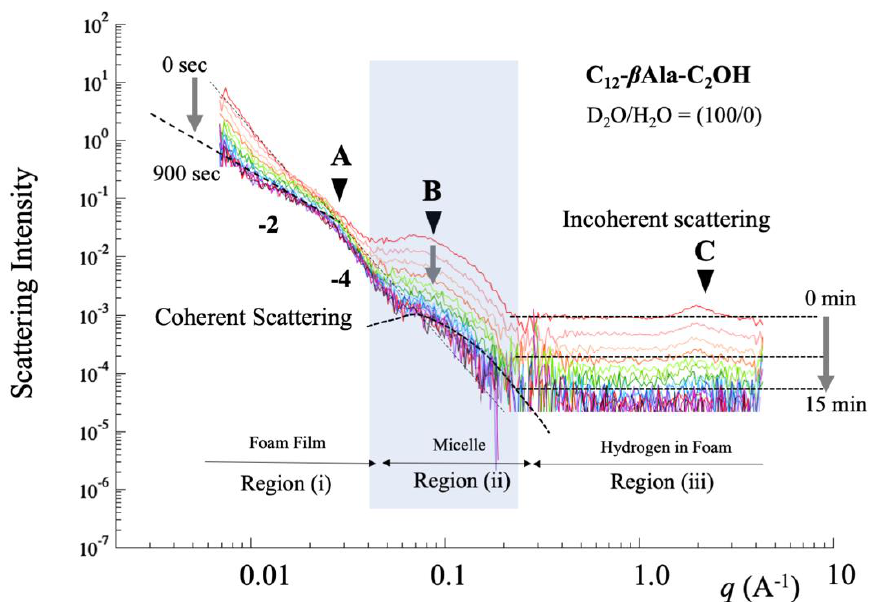
Figure 11. Time-resolved coherent SANS obtained for the C 12 –EtOH– β Ala solution of 100% D 2 O with a time interval of 1 min, covering a wide q -region from 0.01 to 4 A − 1 . At low q values, coherent scattering of the film was dominant, whereas at high q values incoherent scattering of hydrogen was dominant. The characteristic q -positions are indicated by A (= q c ), B, and C, which were attributed to the film thickness, micelle, and deuterated water (D 2 O). The dotted lines are guides for the eye.